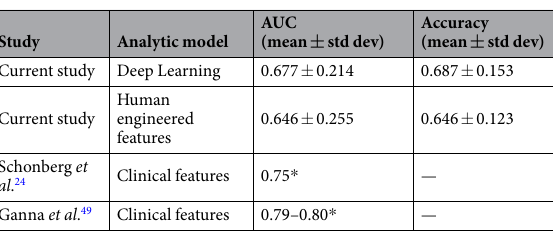
Table 3. Mean and standard deviation of the AUC and accuracy results of the 6-fold cross-validation experiment using the deep learning and human engineered feature models, compared to previously described clinical prognostic scores. * Clinical risk score results were reported as c-index rather than AUC, although in this context these terms are